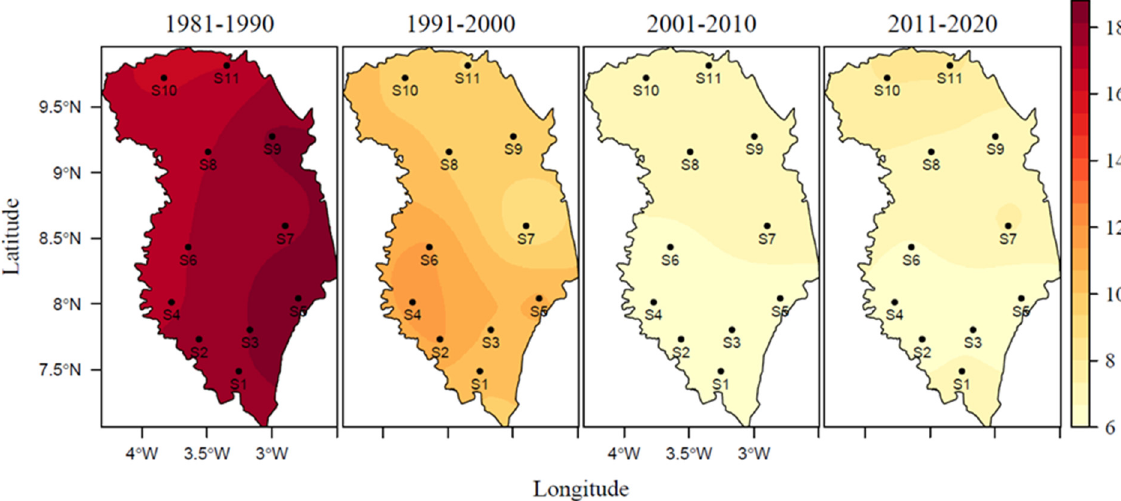
Figure 9. Spatial distribution of number of cold nights (TN10p) (%) per decade in Zanzan region. Stations (S1 = Koun Fao, S2 = Kouassi-dat é kro, S3 = Tanda, S4 = Sandegu é , S5 = Bondoukou, S6 = Nassian, S7 = Sapli, S8 = PN Como é S1, S9 = Bouna, S10 = T é hini, S11 =